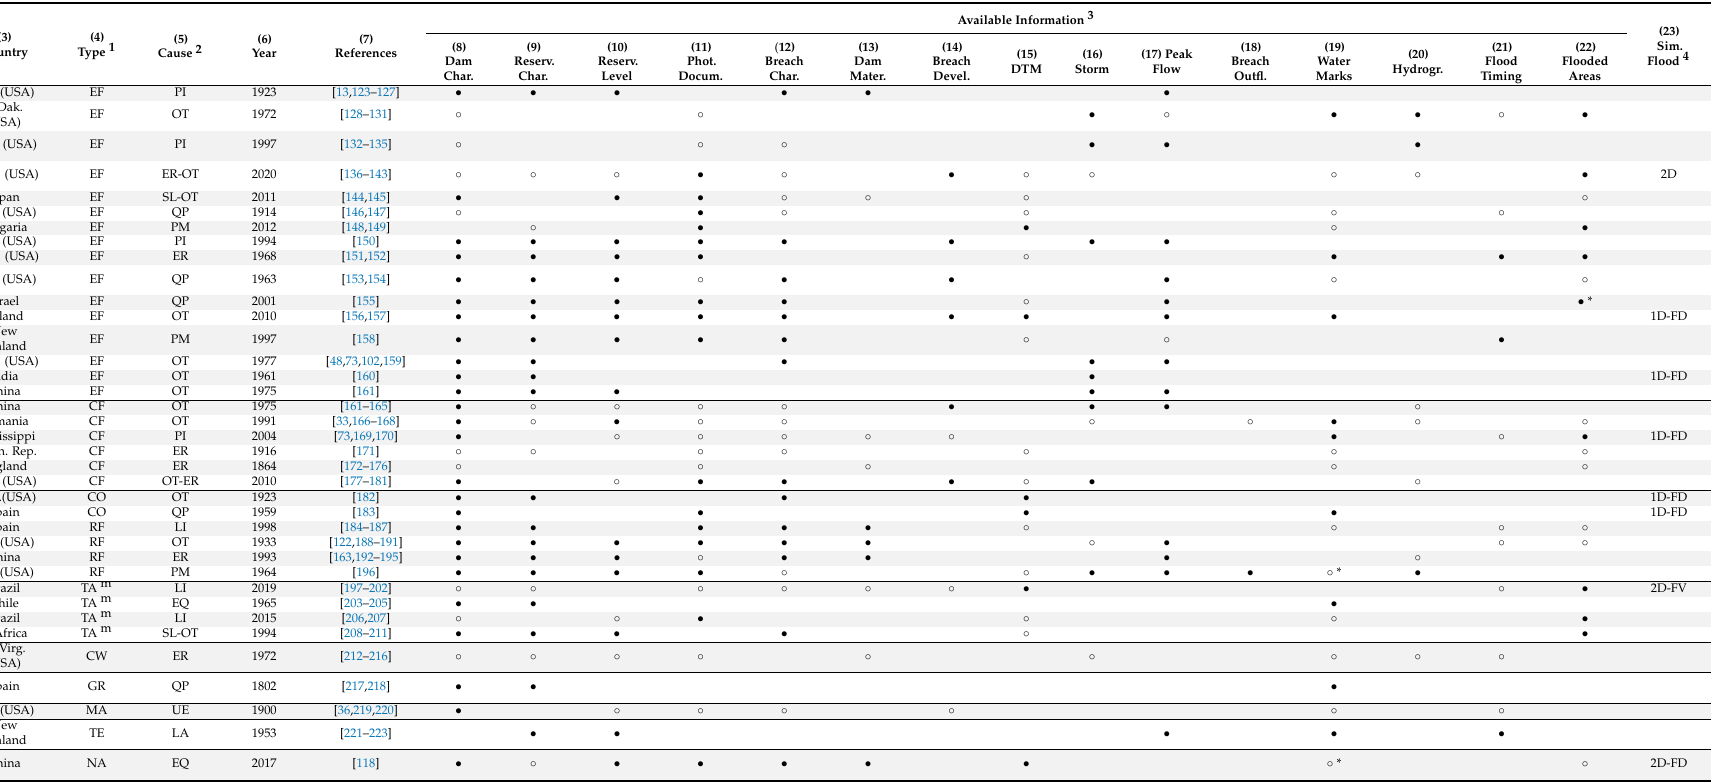
Table 2. Dam-break test cases open to further